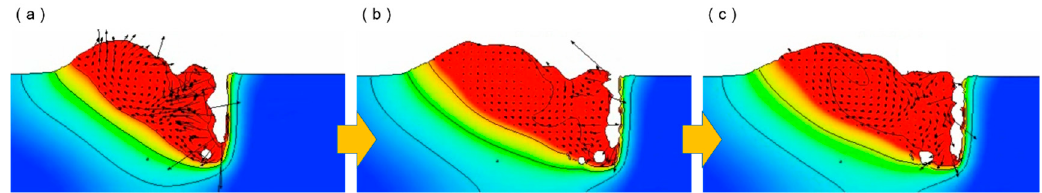
Figure 12. Schematics of bubble merging in the laser welding process with high heat input. ( a ) Bubbles had the probability to adhere and be retained; ( b , c ) Bubbles passing by the mushy zone were likely to collide and merge.